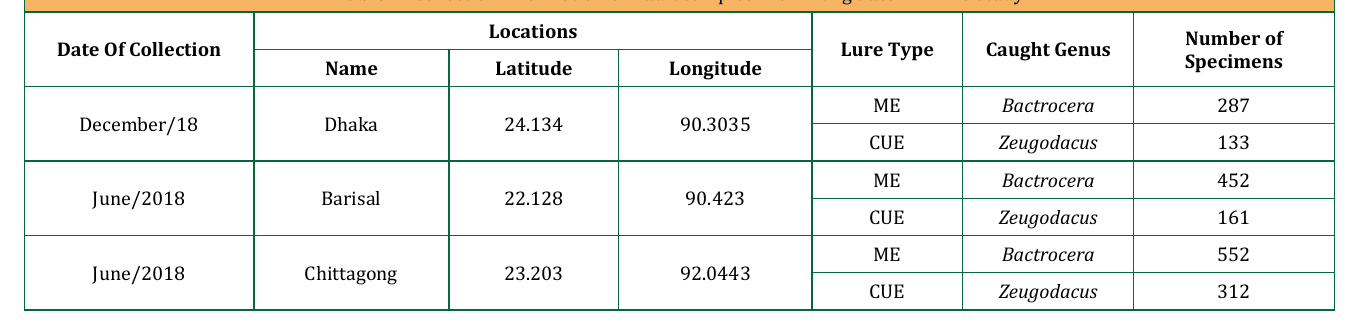
Table 2: Collection Information of Adult Samples From Bangladesh In This Study